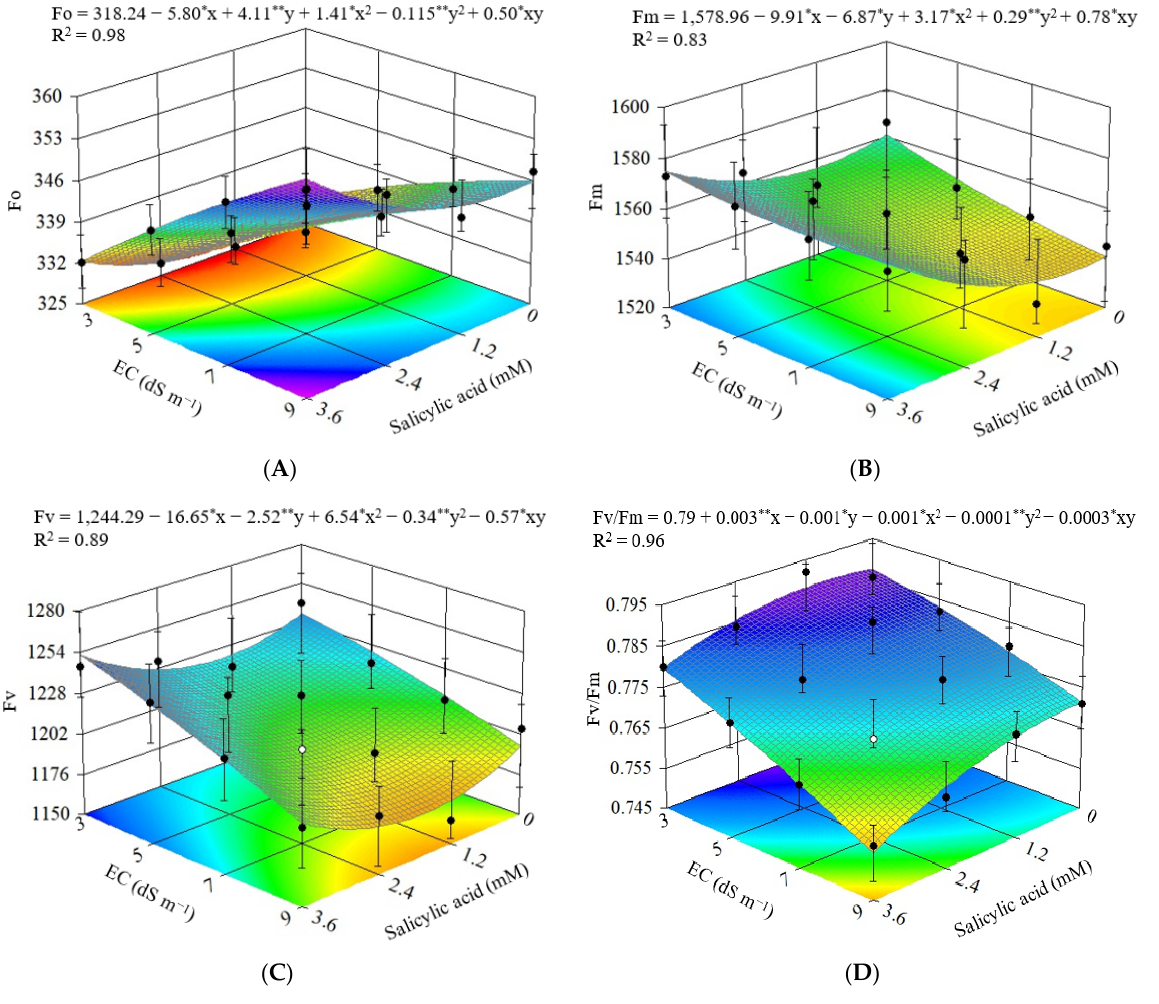
Figure 14. Response surface for initial fluorescence—F 0 ( A ), maximum fluorescence—Fm ( B ), variable fluorescence—Fv ( C ) and the quantum efficiency of photosystem II—Fv/Fm ( D ) of ‘Canindé’ okra cultivated in a hydroponic system as a function of the interaction between the electrical conductivity of the nutrient solution (EC) and the concentrations of salicylic acid (SA), 60 days after transplanting. X and Y—Concentration of salicylic acid and EC, respectively; * and ** significant at p ≤ 0.05 and ≤ 0.01, respectively. The vertical lines represent mean +/ − standard error (n =